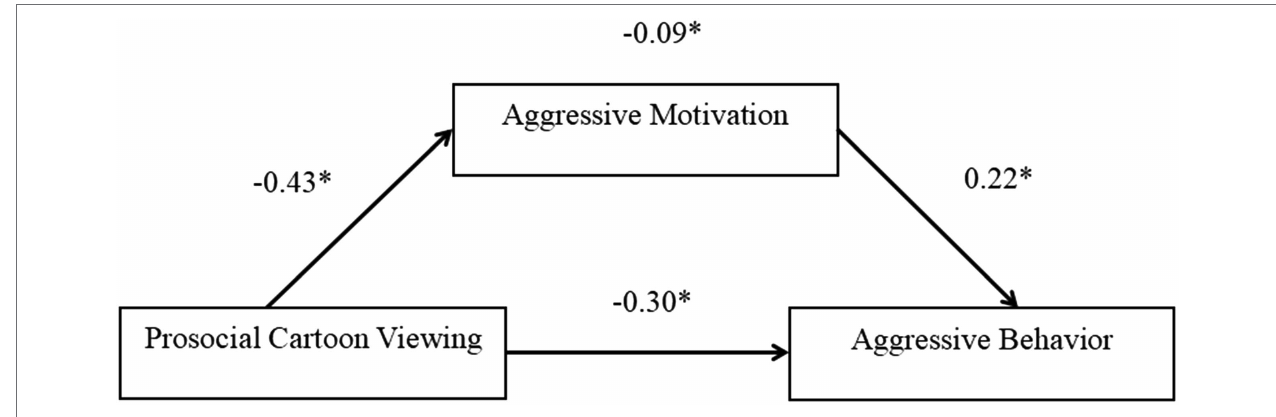
FIGURE 2 | Partial mediation model of prosocial cartoon viewing on aggressive behavior through aggressive motivation. 1 = prosocial and 0 = nonprosocial; standardized path coefficients; and solid lines represent significant paths. * p < 0.05.